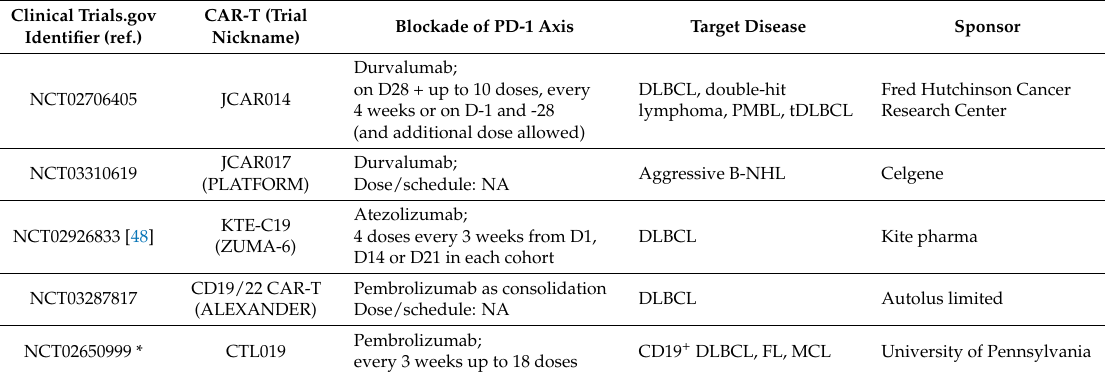
Table 1. Open clinical trials exploring the role of immune-checkpoint blockade with CAR-T cell therapy. Clinical Trials.gov Identifier